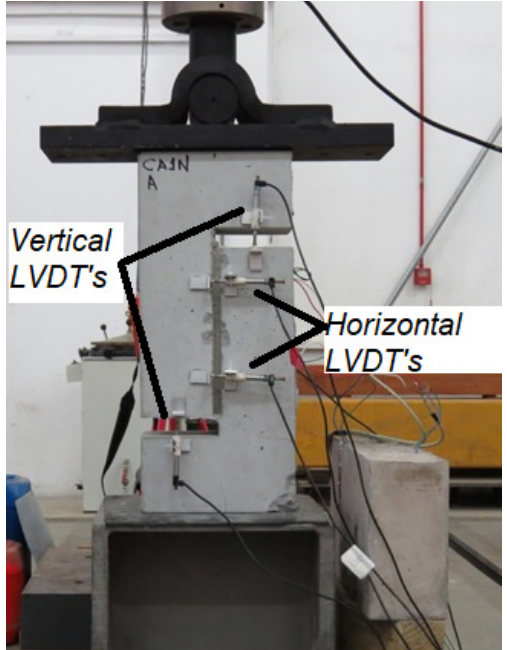
Figure 2. Specimen set-up and